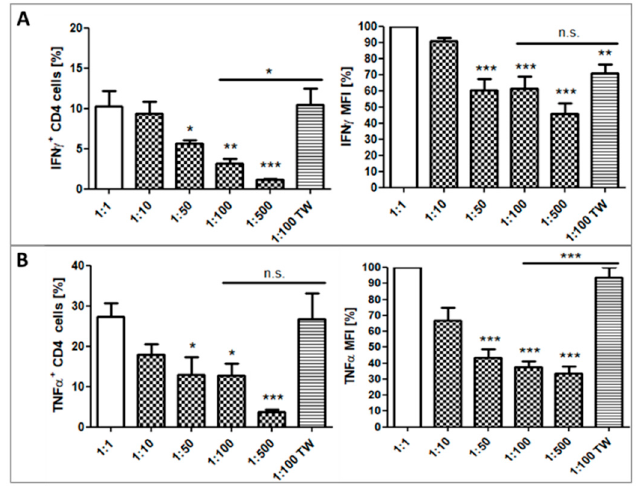
Figure 6. Percentage of IFN- γ ( A ) and TNF- α ( B ) positive CD4+ T cells and Cytokine expression levels (MFI) measured by flow cytometry after PHA stimulated culture for 6 h at a PLT: PBMC ratio of 1:1, 10:1, 50:1, 100:1, 500:1, or 100:1 in Transwell cell culture inserts. Bars show mean + SEM of results from 10 healthy donors. n.s. p ≥ 0.05; * p ≤ 0.05; ** p ≤ 0.01; *** p ≤ 0.001; 1-way Anova with Tukey’s multiple